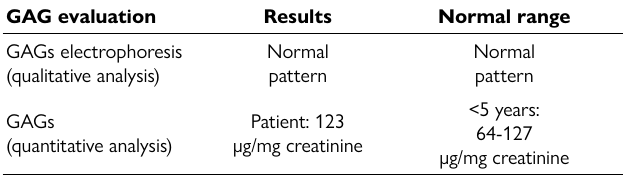
Table 1. Evaluation of urinary GAGs when patient was 4-year-old.